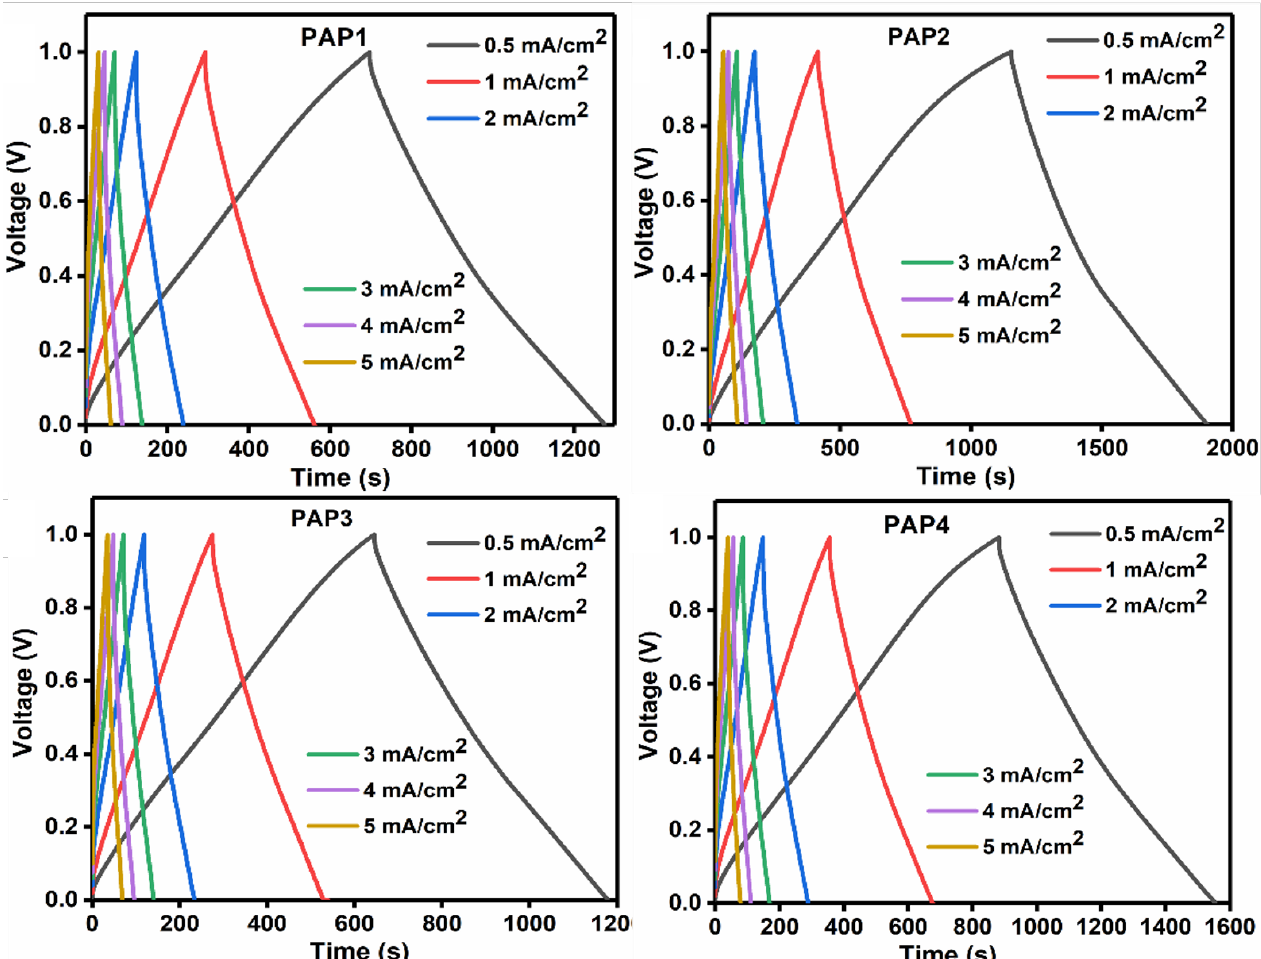
Figure 11. GCD curves of all samples at different current densities.